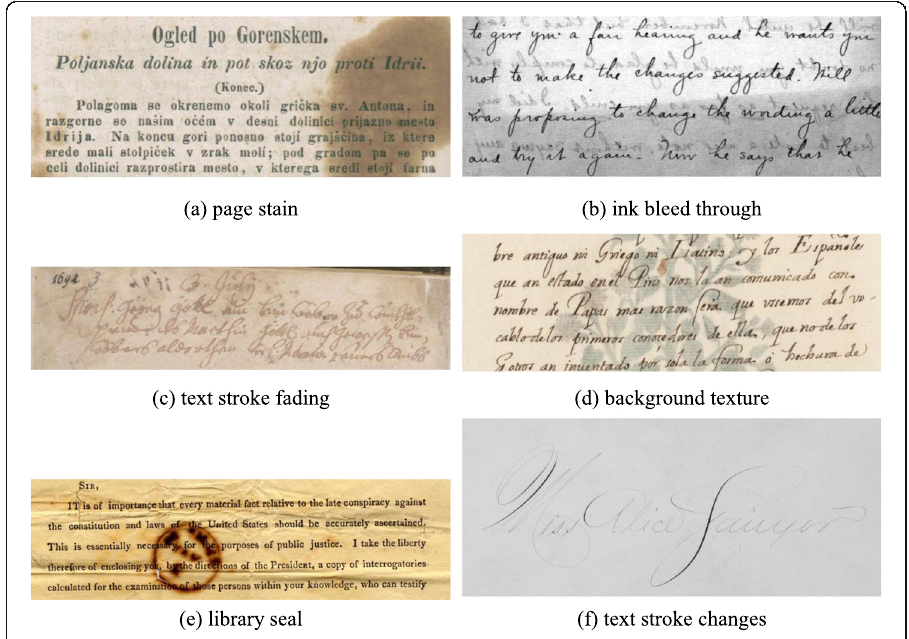
Fig. 1 Historical document image samples in recent DIBCO and H-DIBCO benchmark